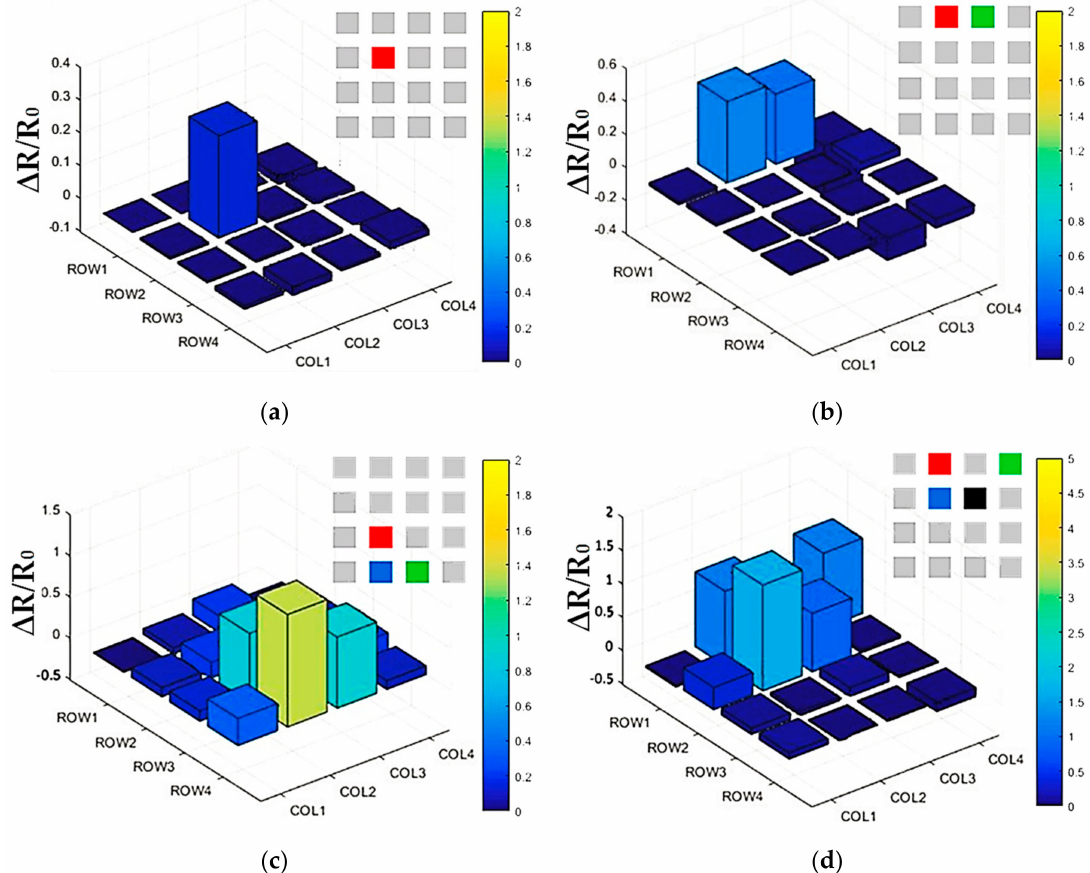
Figure 9. The distribution of tactile data from the flexible tactile sensor array during finger touching under different conditions: ( a ) Only one sensing unit being tested; ( b ) Two sensing units being tested; ( c ) Three sensing units being tested; ( d ) Four sensing units being tested. Illustration in each picture shows the finger touch